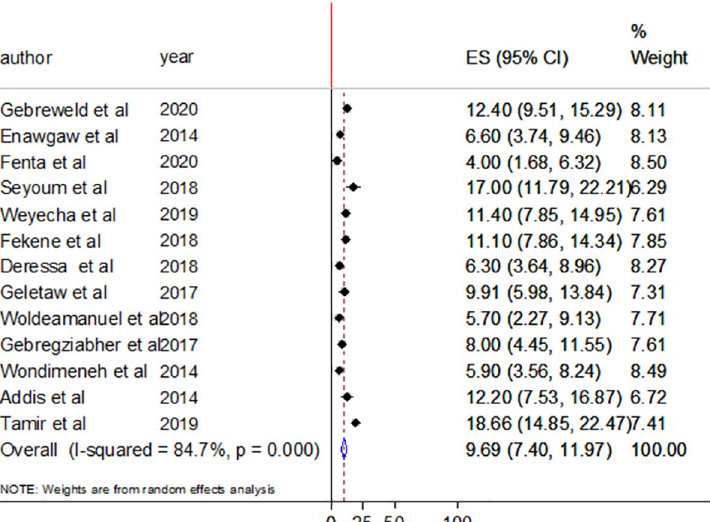
Fig 2. Forest plot showing the pooled prevalence of thrombocytopenia among people living with HIV/AIDS in Ethiopia.